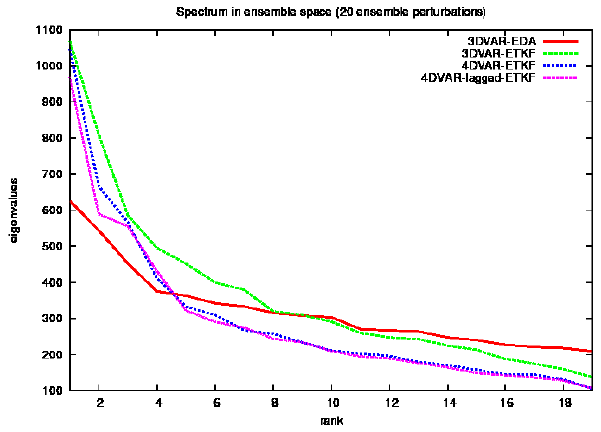
Fig. 17. Ensemble perturbation spectra in ensemble space calcu- lated from differences between ensemble members and ensemble control in observation points. 22 January 2008 12:00UTC + 6h. 3D-Var hybrid with EDA perturbations (eda_hybrid1, red curve), 3D-Var hybrid with ETKF perturbations (3dvar_hybrid1, green curve), 4D-Var hybrid with ETKF perturbations (4dvar_hybrid1, blue curve) and 4D-Var hybrid with ETKF perturbations including also a lagged valid time ensemble (4dvar_hybrid2, pink curve).